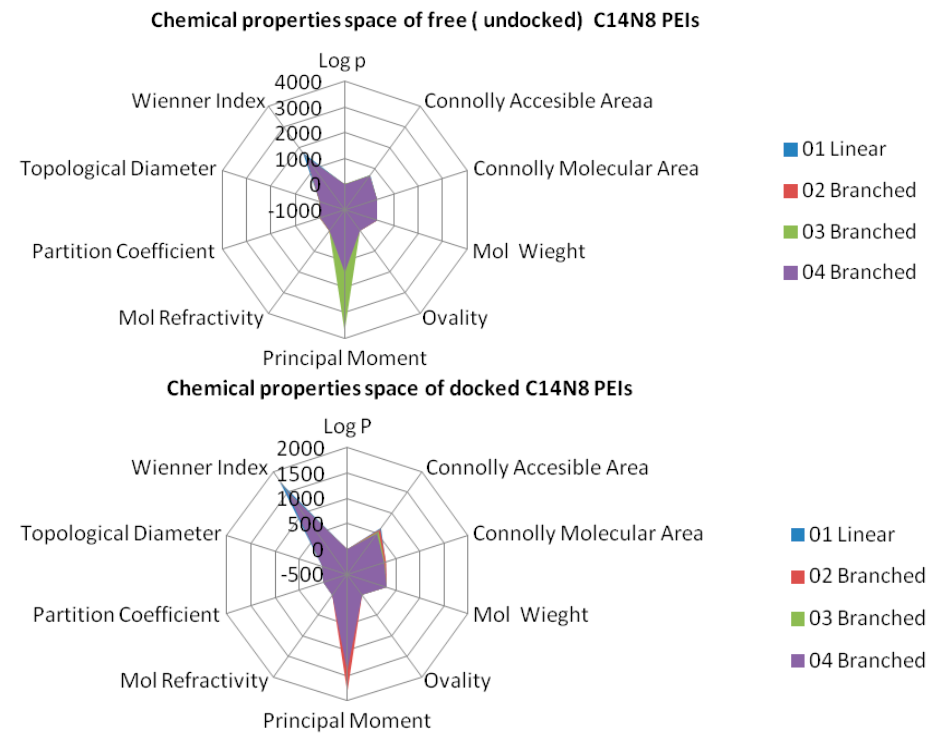
Figure 5. Chemical property space of C14N8 PEIs before ( top ) and after docking ( bottom ).